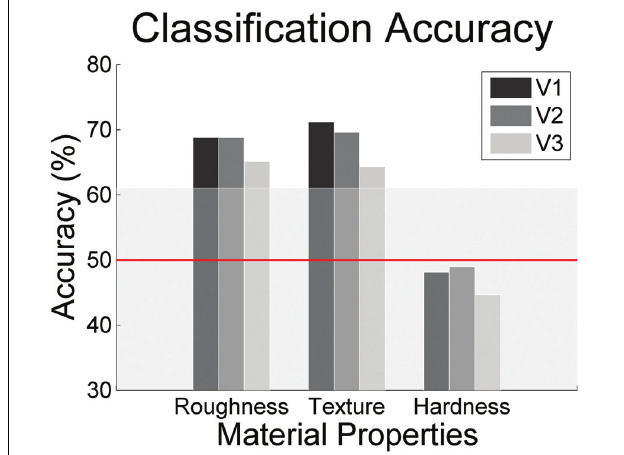
FIGURE 3 | Classification accuracies of a discriminant analysis in retinotopically defined visual areas V1-V3 (nine participants). Again, the horizontal line indicates chance level (0.5). The shaded area indicates the p -threshold resulting from the permutation test ( p < 0.05, one-tailed test). The threshold was averaged across all participants.